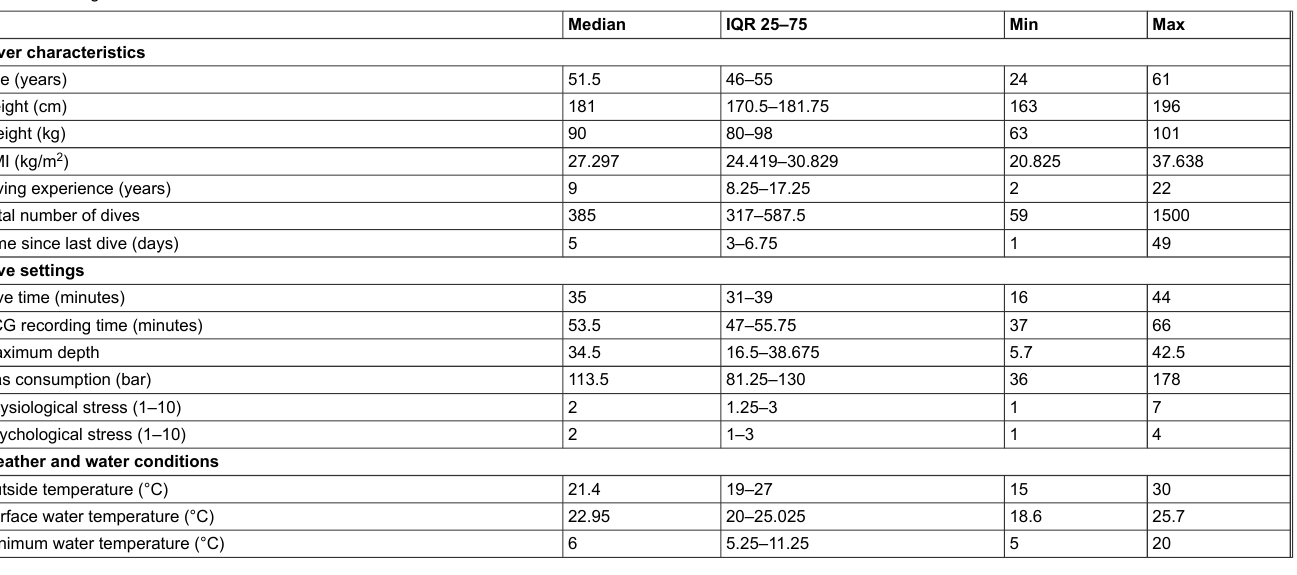
Table 1: Diver and diving